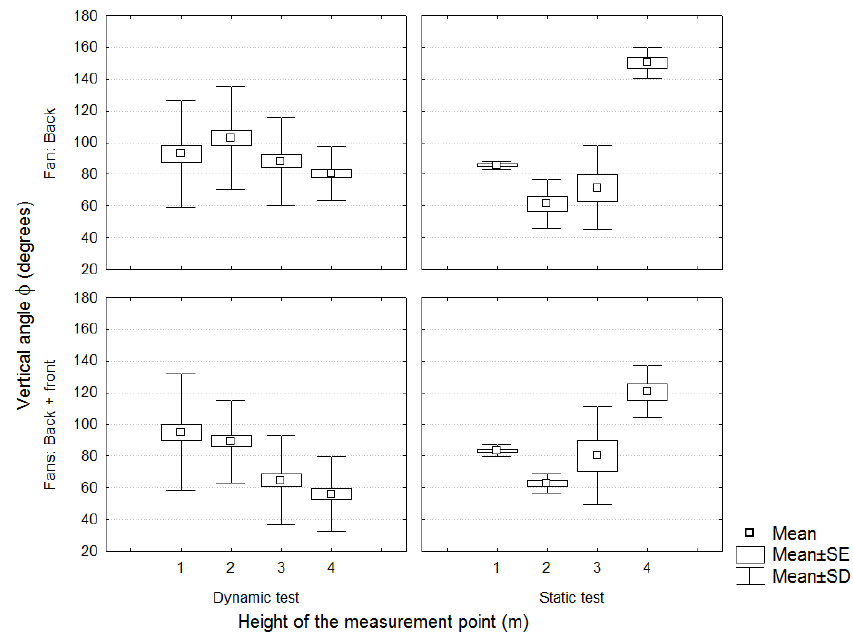
Figure 16. Dynamic versus static test. Fan blades’ position = 3. Vertical angle of the velocity vector in function of the measuring height and the number of activated fans. Static values measured in section